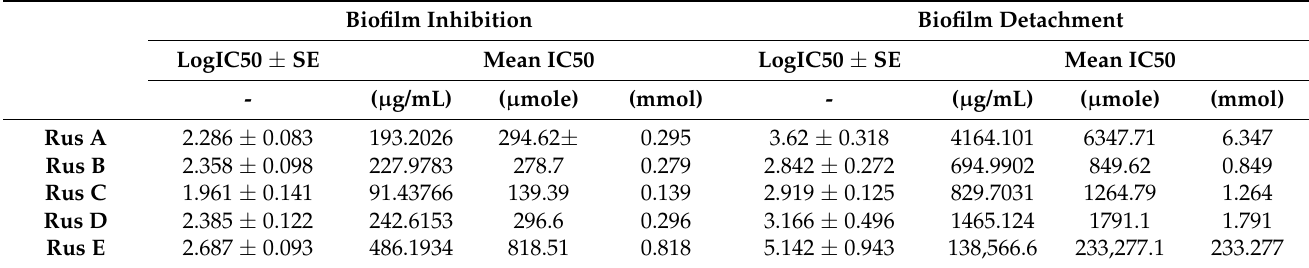
Table 1. IC50 of the five isolated Caralluma quadrangula compounds ( Rus A – E ) against MRSA USA300 biofilm.